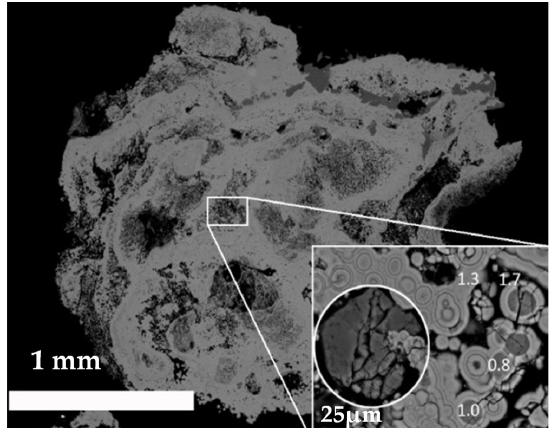
Figure 5. Globular apatite with a high F concentration in the center of the oxalate-bearing kidney stone, Sample 14. BSE image.